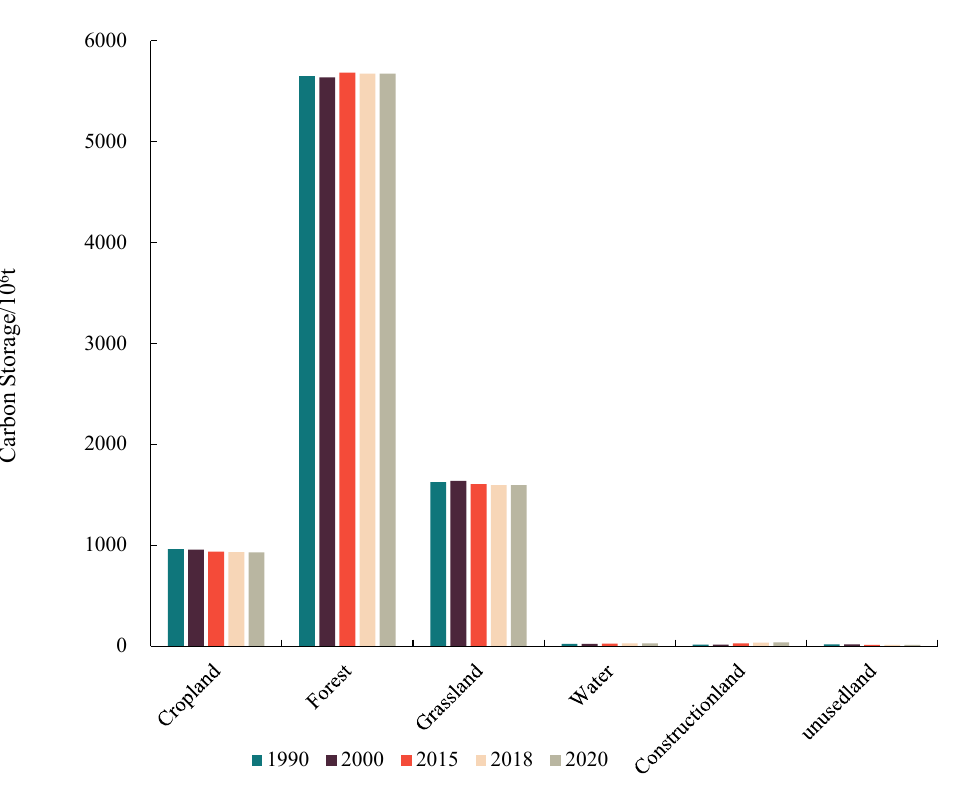
Figure 4. Carbon stock share of ecosystems in Yunnan Province from 1990 to 2020.